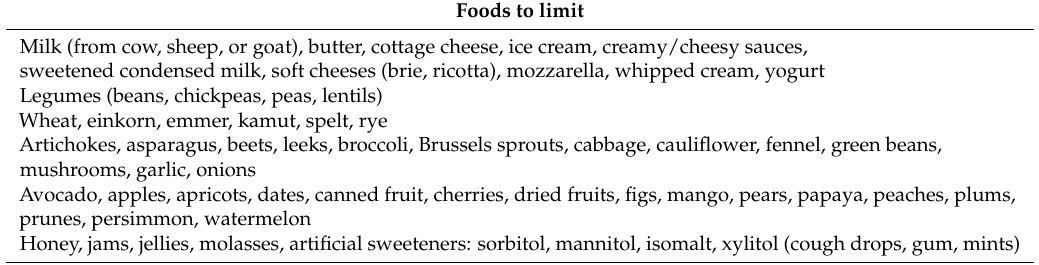
Table 8. Low FODMAPs diet. Foods to